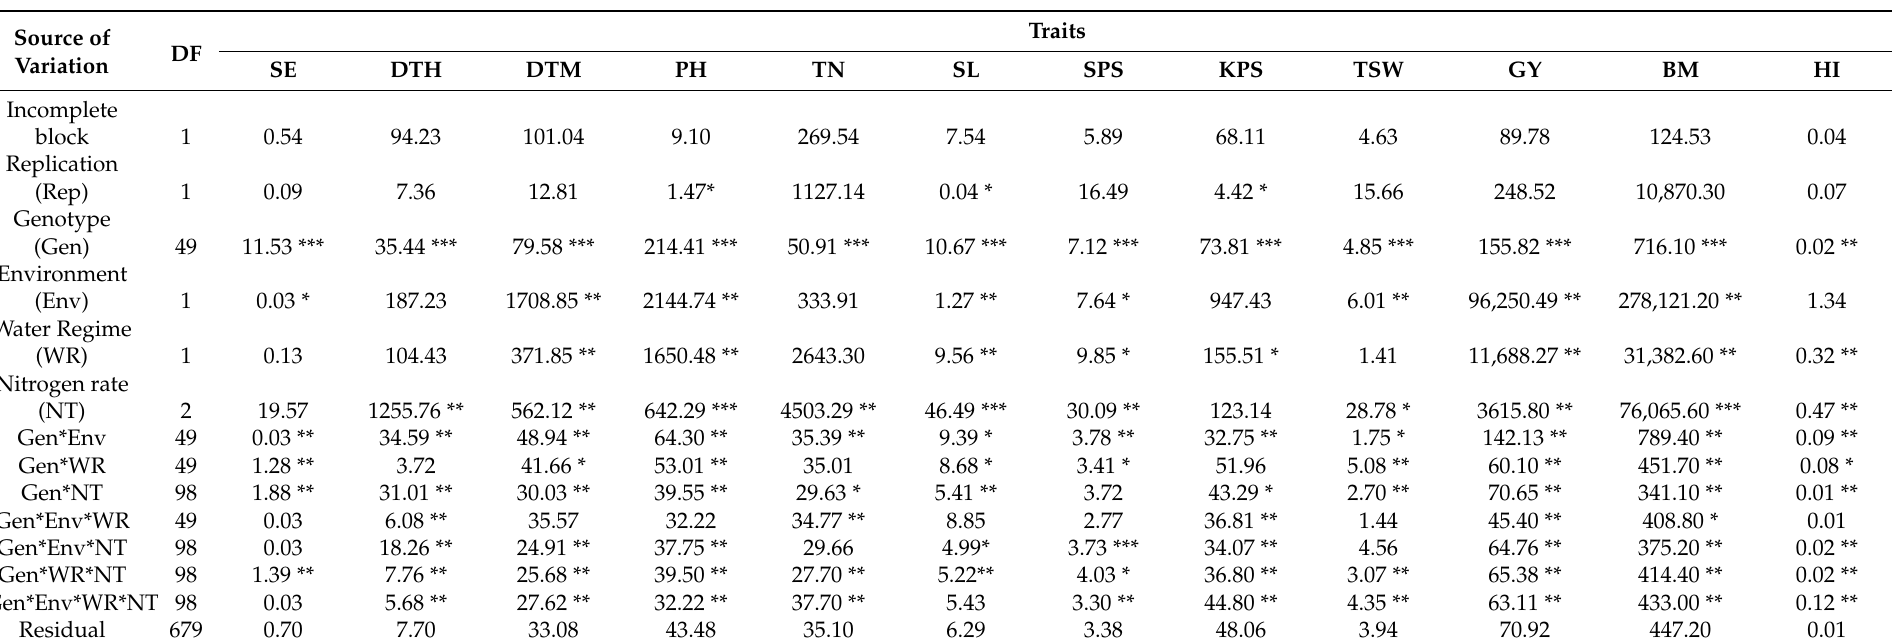
Table 4. Mean squares and significant tests after combined analysis of variance for 12 phenotypic traits of 50 wheat genotypes evaluated in two sites under drought stress (DS) and non-stressed (NS) conditions, three nitrogen treatments, and two